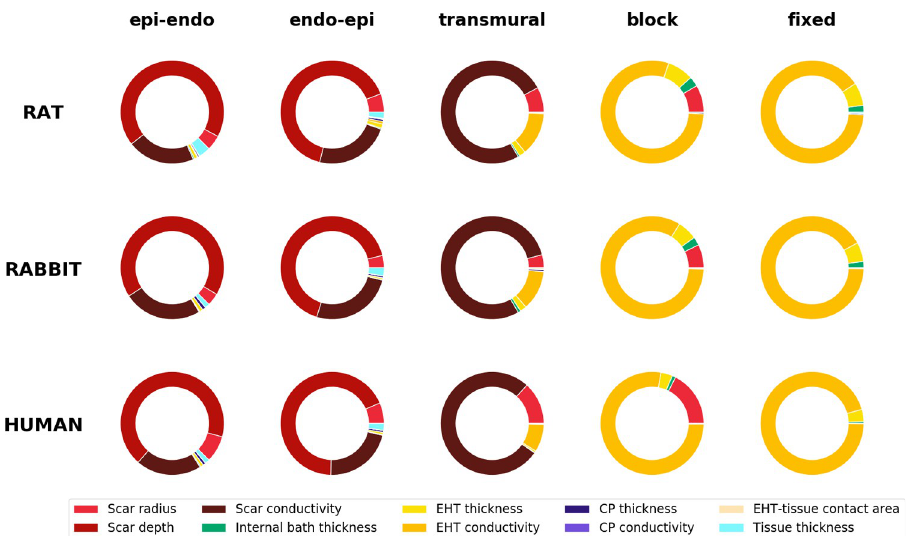
Fig 5. Donut charts representing the total effect index from the GSA. The figure compares the total effect indices obtained from the rat, rabbit, and human models (rows), for the epi-endo and endo-epi versions of the model and the transmural, block and fixed model sub-cases (see section